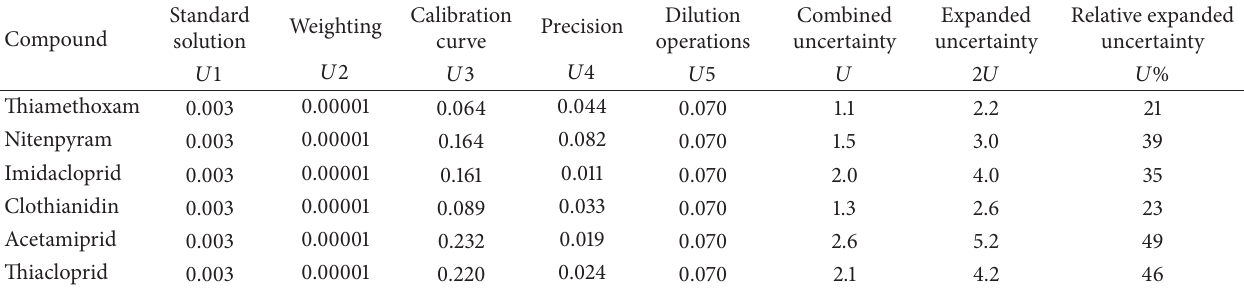
Table 3: Results of individual and combined uncertainties for each pesticide calculated at 10 𝜇 g/kg concentration level. Compound